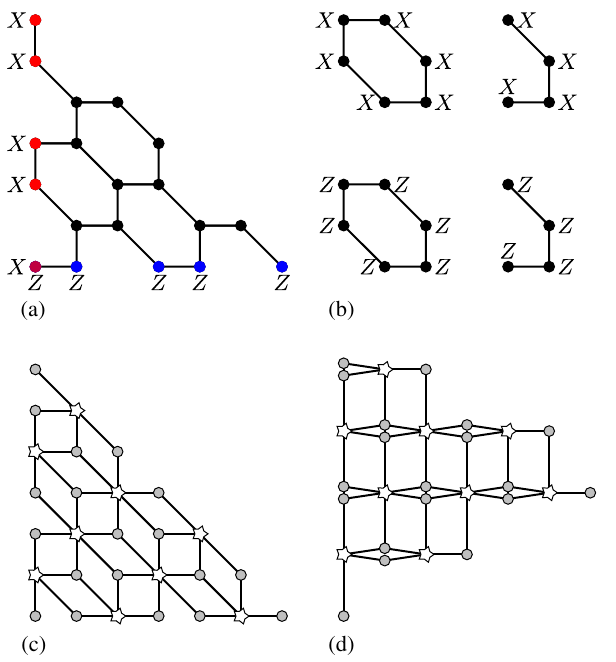
FIG. 21. Decoder convergence for the distance d ¼ 19 triangu- lar 6.6.6 color code, represented by shifted logical failure rate f χ − f 36 , as a function of χ at a physical error probability p near the threshold for the given bias η . Each data point corresponds to 60 000 runs with identical errors generated across all χ for a given